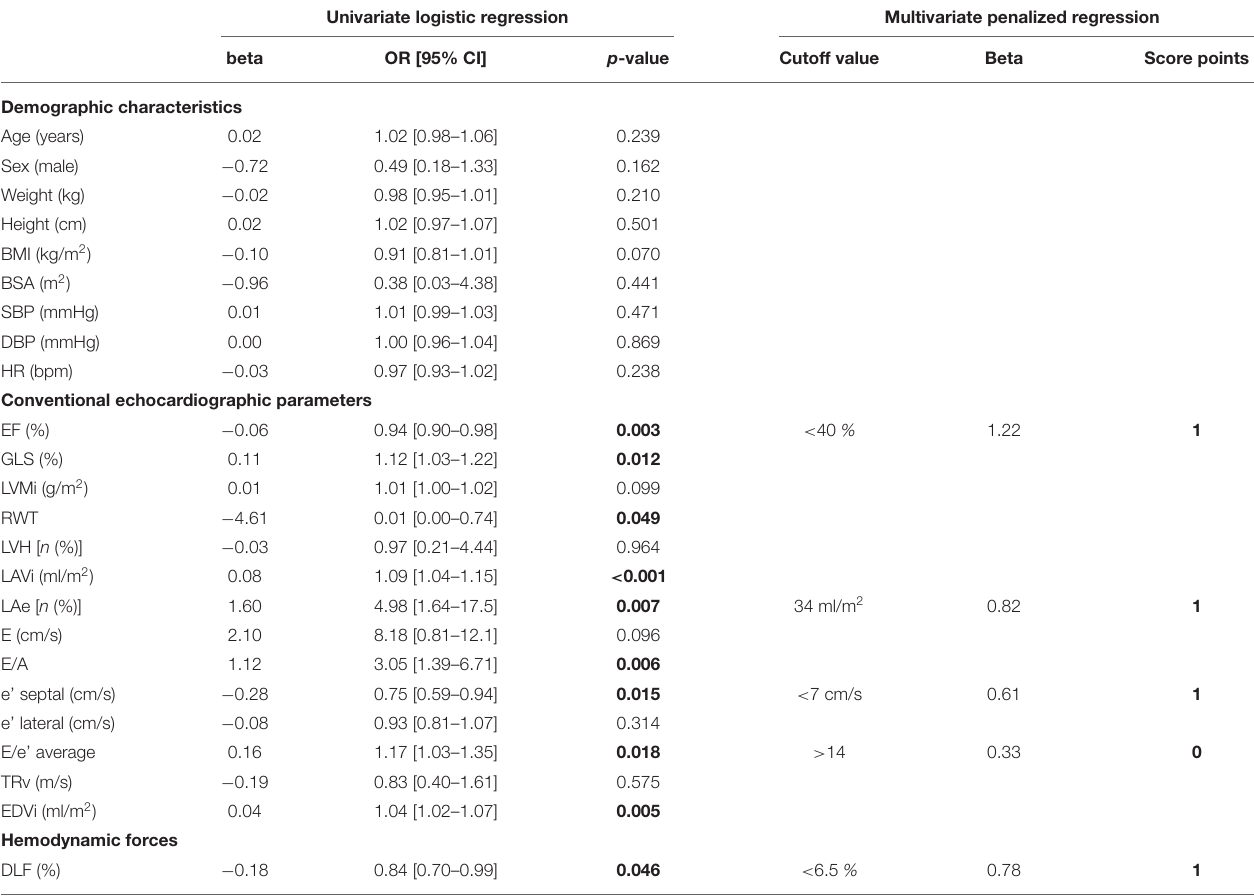
TABLE 2 | Univariate logistic regression and multivariate penalized regression. Univariate logistic regression Multivariate penalized